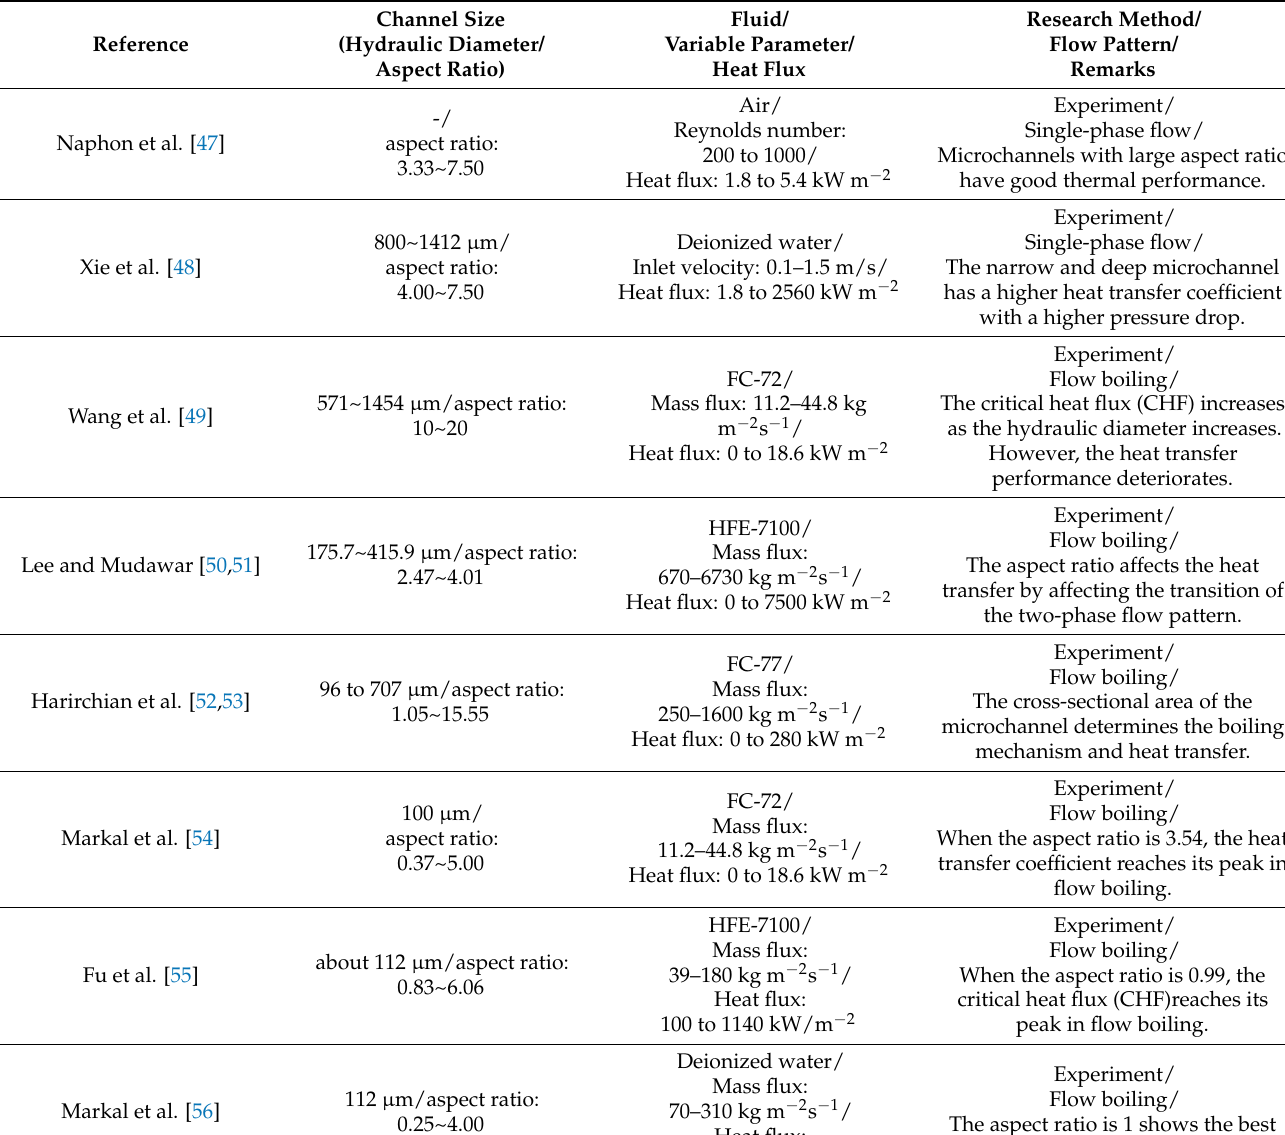
Table 2. Selected studies of aspect ratio on heat